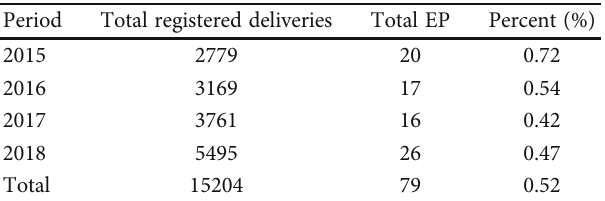
Table 3: Yearly distribution of ectopic pregnancy per number of registered deliveries in Aksum (AKUCSH and Saint Marries General Hospital), Tigray, Ethiopia,